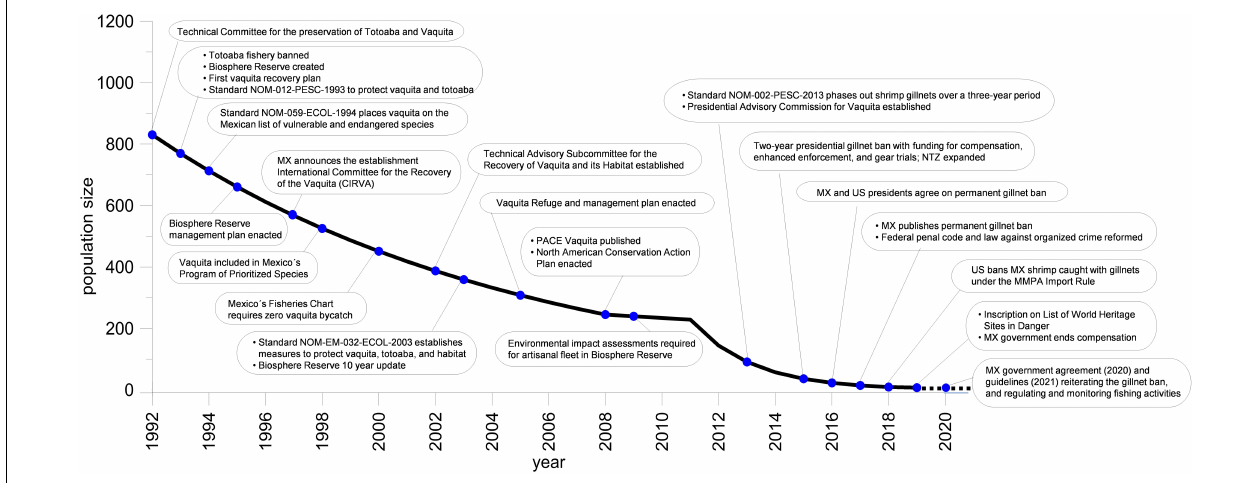
FIGURE 2 | The decline of vaquitas has been continual despite many laws and regulations being enacted to reduce vaquita bycatch, but not resulting in the elimination of gillnets in vaquita habitat. See text and reviews in Rojas-Bracho et al. (2006), Bobadilla et al. (2011), Rojas-Bracho and Reeves (2013), and Cisneros-Montemayor and Vincent (2016) for more information. Figure with schematic depiction of vaquita population trajectory adapted from Comité Internacional para la Recuperación de la Vaquita [CIRVA] (2014), Jaramillo-Legorreta et al. (2019), and Rojas-Bracho et al. (2020). TABLE 1 | Summary of payments to fishers by the Government of Mexico to implement actions to protect vaquita from gillnets, 2007–2018. Policy Instrument Expenditures Intentions